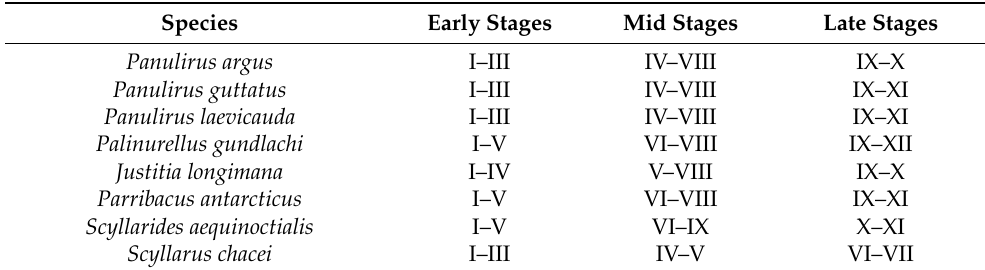
Table 1. Categorization of individual phyllosomata stages of eight Achelata species into early stages, mid stages, and late